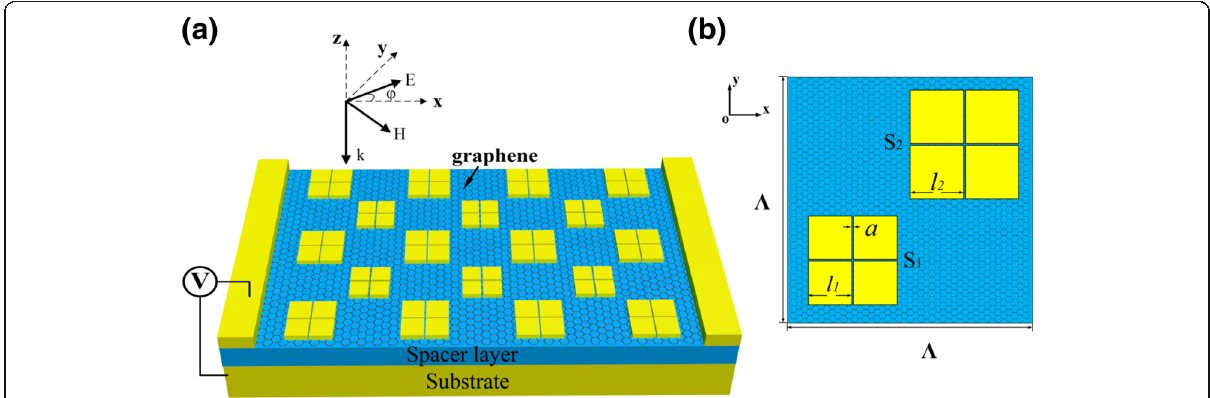
Fig. 1 a Schematic diagram of the proposed graphene-loaded metamaterial. The cross-shaped slot in each subunit enables a great enhancement of graphene-light interaction without polarization dependence. b Top view of the structure in one period. Two subunits are arranged diagonally with different patch